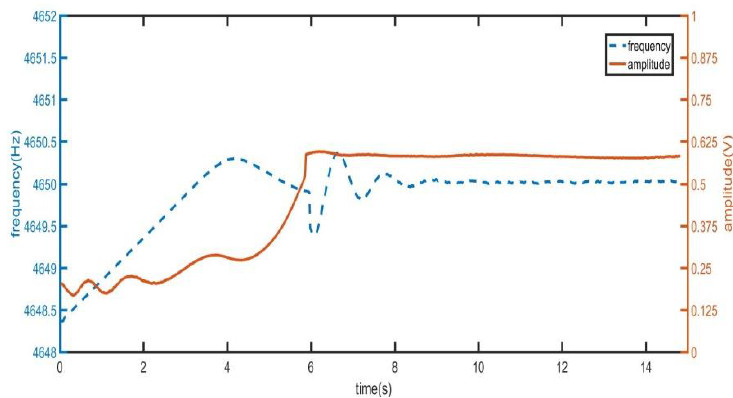
Figure 20. Changes in frequency and amplitude at start-up.